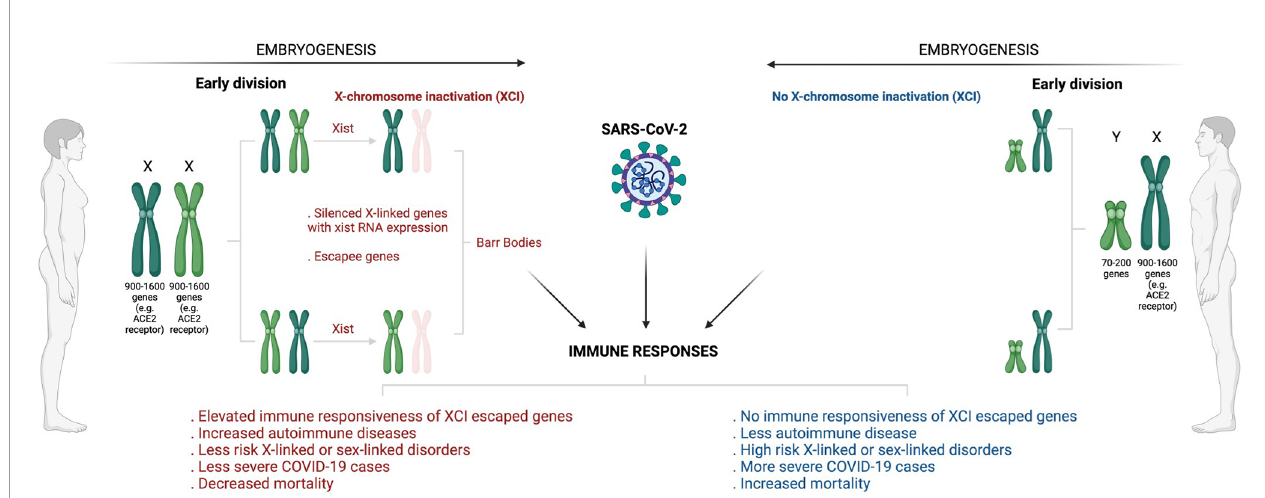
FIGURE 3 | Overview of sex-based differences in the immune response to COVID-19. The diagram shows how X-chromosome inactivation escapee genes may underlie sex bias differences in COVID-infection, severity, and mortality. Sex-bias differences in COVID-19 may be linked to ACE2, the primary receptor that enables SARS-CoV-2 infection. Having double X-chromosomes protects women against increased susceptibility to COVID-19 infection and associated severe complications as compared to men who have just a single X-chromosome. ACE2 is an X-chromosome-linked gene that escapes X-inactivation, a phenomenon that suppresses gene transcription from one of the two X chromosomes in female mammalian cells to balance expression dosage between XX females and XY males. This means that women have twice more genetic instructions to transcribe ACE2 and many more X-chromosome-linked immunoregulatory genes that protect women from increased COVID-19 susceptibility and associated severe complications. (Created with BioRender.com). ACE2, Angiotensin I-converting enzyme-2; COVID -19, Coronavirus disease 2019; SARS-CoV-2, Severe acute respiratory syndrome coronavirus 2; XCI, X-chromosome inactivation; XIST, X-inactive speci fi c